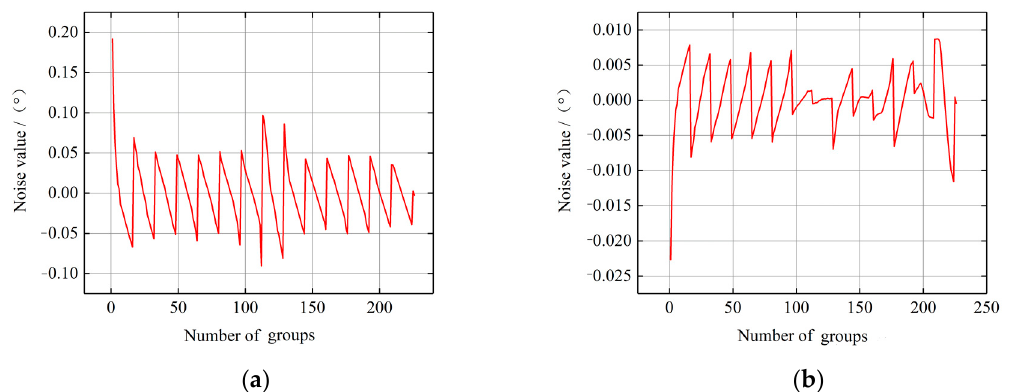
Figure 4. Example noise sequences. ( a ) Longitude noise sequence; ( b ) Latitude noise sequence.